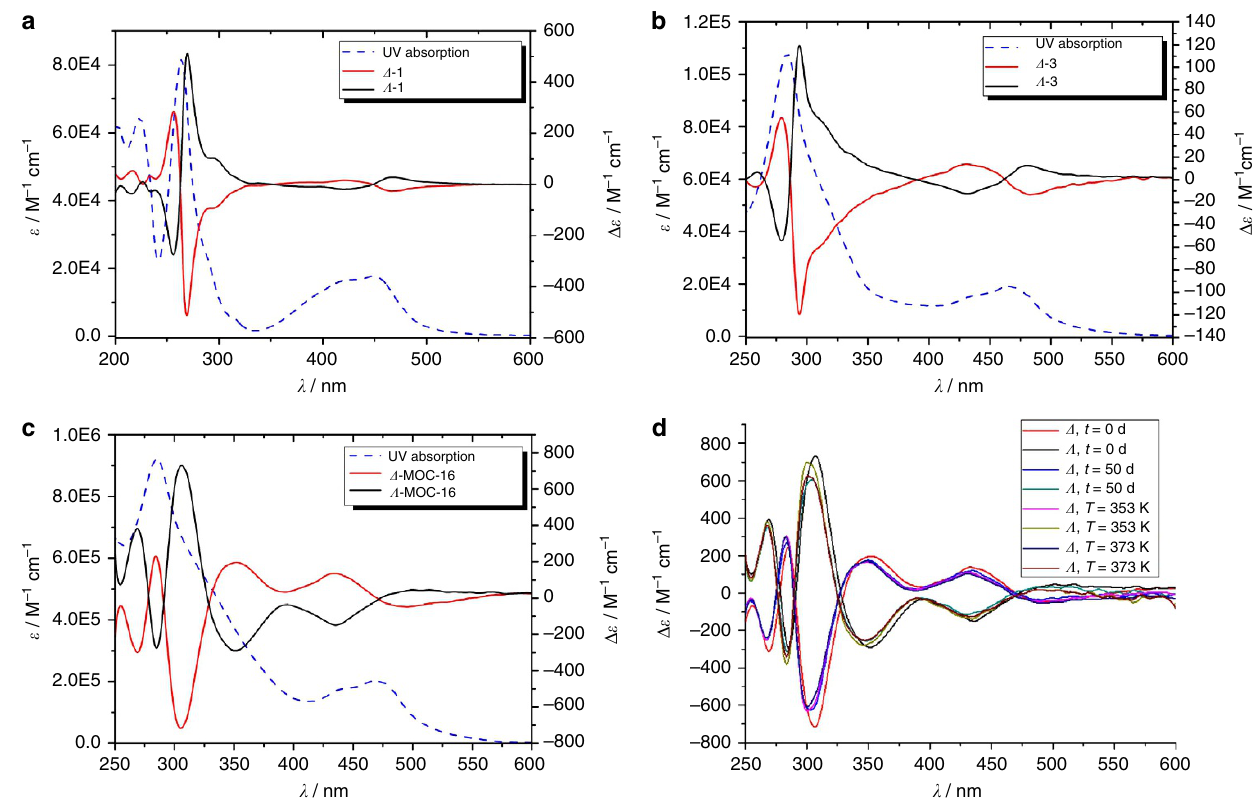
Figure 3 | CD and UV spectra. CD (solid lines) and ultraviolet (dotted lines). ( a ) D - and L -1 in MeCN, ( b ) D - and L -3 in DMSO, ( c ) D - and L -MOCs-16 in H 2 O and ( d ) the stereochemical stability depending on time and temperature.